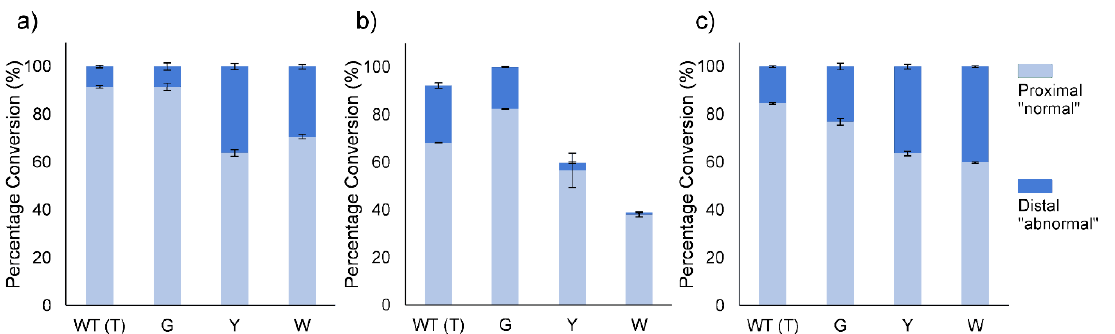
Figure 4. Effect of amino acid substitution at T513 on regioselectivity of BVMO AFL210 towards 2-methylcyclopentanone ( a ), 2-methylcyclohexanone ( b ) and cis -bicyclo[3.2.0]hept-2-en-6-one ( c ). Reactions conditions: 1 mL reaction volumes containing 0.1g cells (wet weight) in 40 mL amber vials, buffer: 200 mM Tris pH 8, 100 mM glucose, 100 mM glycerol, 5 mM substrate shaking: 200 rpm, 20 °C, 24 h